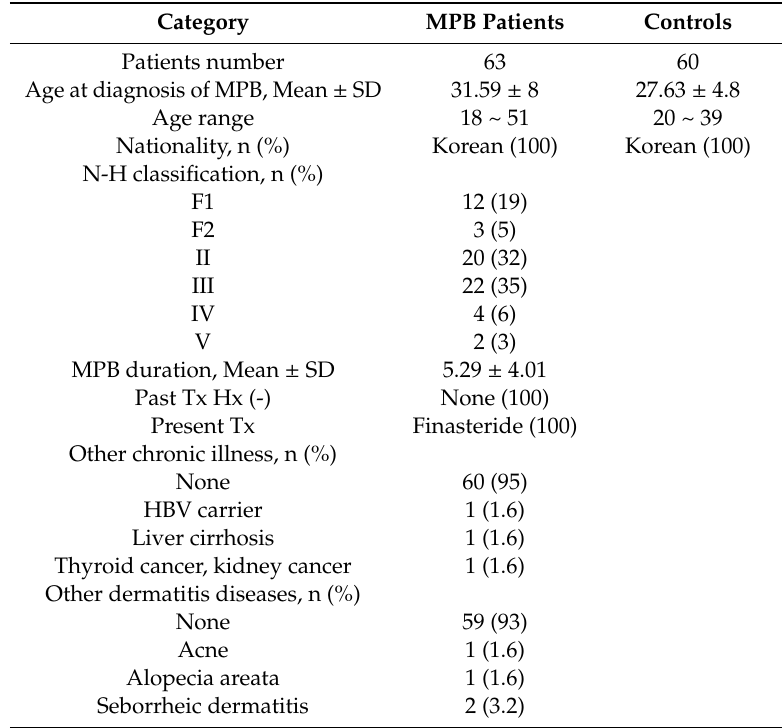
Table 2. Clinical characteristics of the study